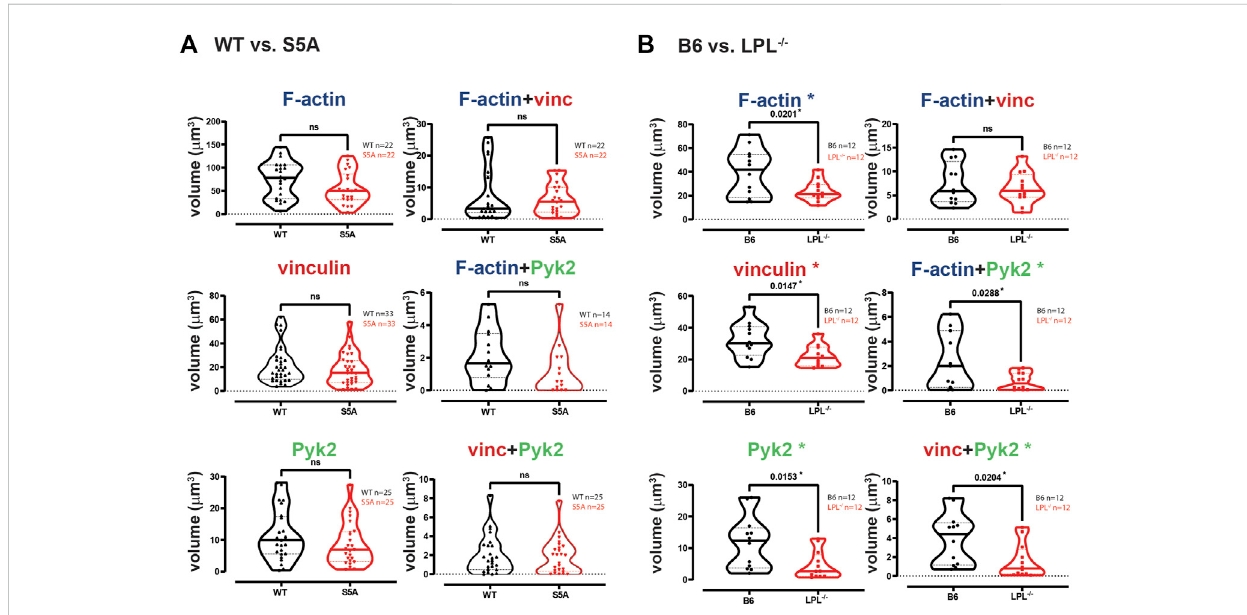
FIGURE 3 Quanti fi cation of volumes of protein aggregates reveals loss of Pyk2 from podosomes in AMs lacking LPL. Imaris software was used to calculate the total volume ( μ m 3 ) of the indicated protein 3D aggregates (images in Figure 2) contributing to podosome formation after serum stimulation of AMsderived from (A) matchedWTandS5Amice or (B) matchedB6and LPL − / − mice. Eachsymbolrepresentsthevolumecalculatedfromone fi xedcell;n= numberof cellsanalyzed.Imagesacquiredfrom two independentexperiments. p -valuesdeterminedbyMann-Whitney;ns=non-signi fi cant,*= p <